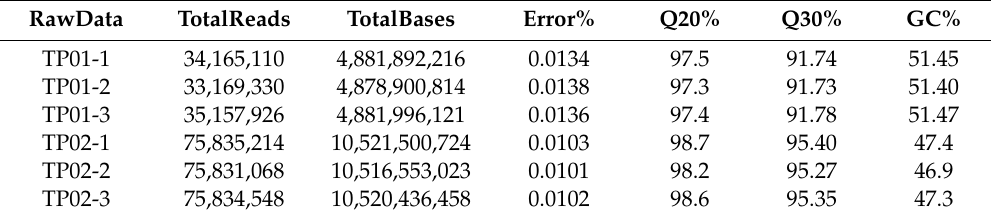
Table 1. Basic data of RNA sequencing in the samples of TP01 and TP02.